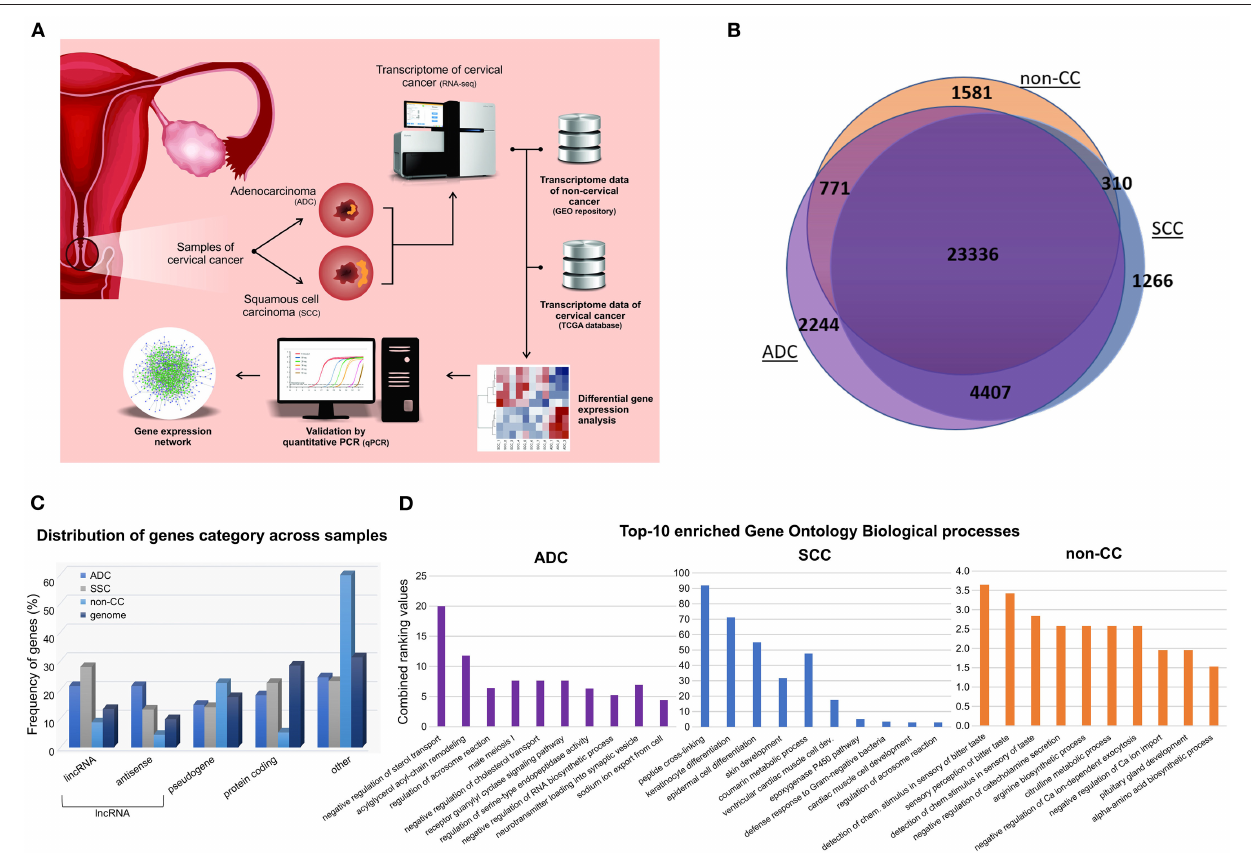
FIGURE 1 | General design and descriptive results of cervical cancer transcriptome analysis. (A) Pipeline applied in cervical squamous cell carcinoma (SCC) and cervical adenocarcinoma (ADC) samples from our study, followed by inclusion of publicly available HPV-negative non-tumoral cervical tissue (non-CC) samples [10] and cervical SCC and ADC samples from The Cancer Genome Atlas (TCGA). Gene expression of SCC, ADC, and non-CC samples was evaluated. Expression levels of selected long non-coding RNA (lncRNA) genes differentially expressed between cervical ADC and SCC were validated by quantitative real-time PCR. Gene expression networks were predicted using gene expression profiles. (B) Number of genes expressed in SCC and ADC samples from this study and non-CC samples. (C) Frequency of genes expressed in cervical SCC, ADC, and non-CC samples, according to protein-coding, lncRNAs genes, and pseudogenes categories (x-axis). LncRNA genes were subdivided in antisense and long intergenic non-coding RNA (lincRNA), according to Ensembl database annotation (GRCh37/hg19 version). (D) Bar chart of top 10 enriched Gene Ontology biological processes based on gene expression profiles of cervical ADC and SCC samples from our study and non-CC samples, according to combined ranking values (y-axis) calculated by Enrichr